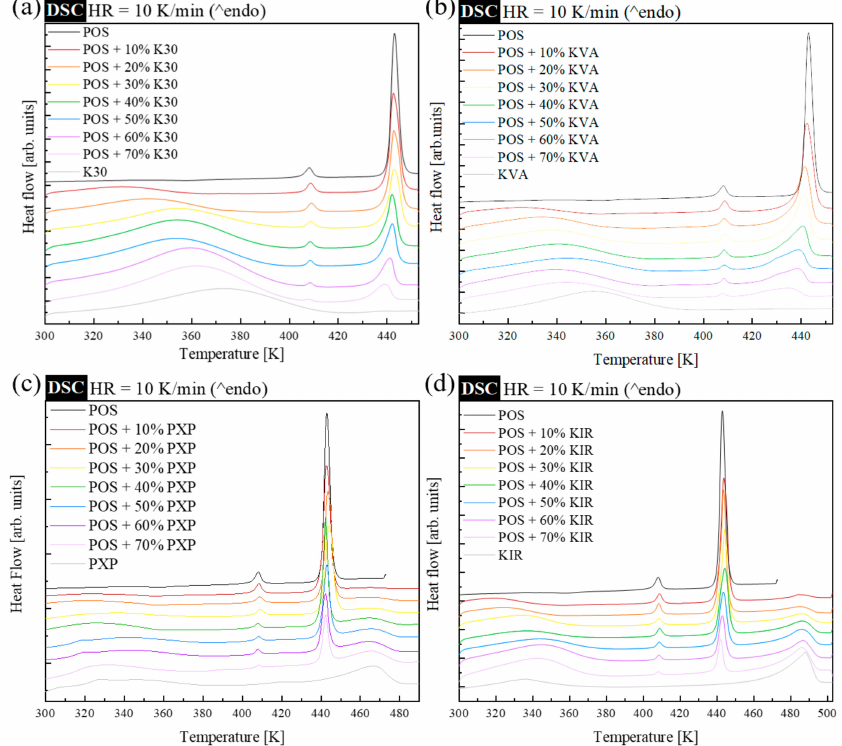
Figure 2. DSC thermograms of physical mixtures containing crystalline POS and, from 10–70 wt.%, of ( a ) Kollidon 30 (K30), ( b ) Kollidon VA64 (KVA), ( c ) Parteck MXP (PXP), and ( d ) Kollicoat IR (KIR). In each panel, the uppermost thermogram represents a DSC trace of neat crystalline (as-received) POS, while the lowest thermogram originates from neat (as-received)